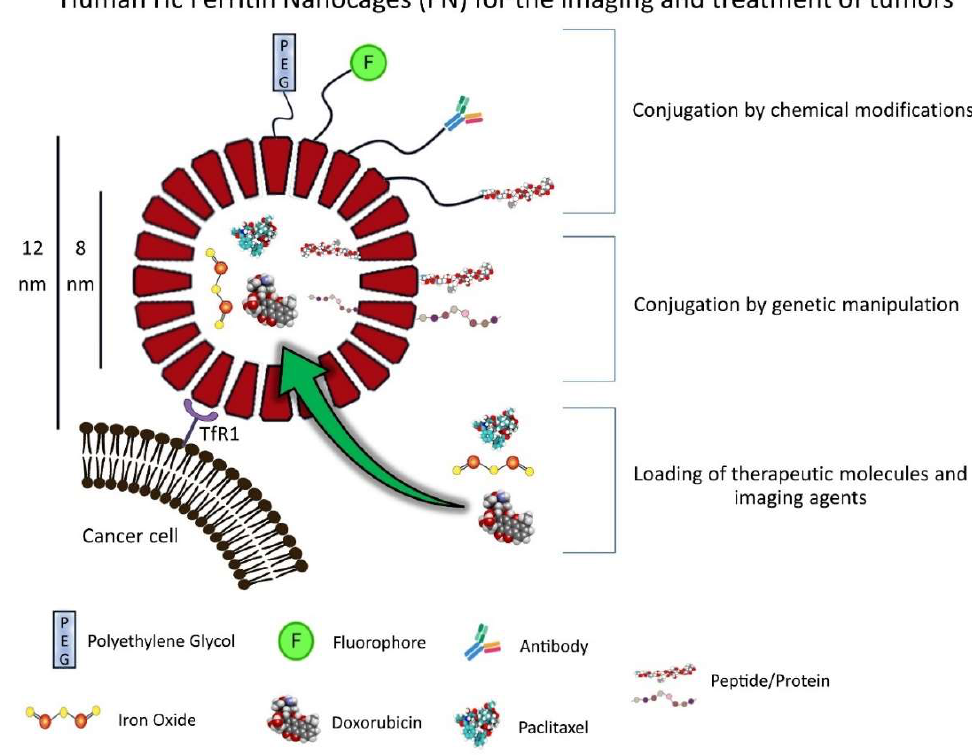
Figure 1. FN as a protein-based delivery system for oncological therapeutics and imaging agents. FNs are composed of 24 Hc subunits that can be chemically or genetically modified to couple a large variety of molecules (antibodies, peptides, fluorophores, polyethylene glycol (PEG) and others) to their surface (N-terminus) or internal cavity (C-terminus). Furthermore, FNs can be loaded with different drugs and imaging agents and have intrinsic targeting capabilities toward the receptor TfR1, which is overexpressed in many tumors. This cartoon was created by using BioRender (https://biorender.com/ accessed on 2 November 2021).